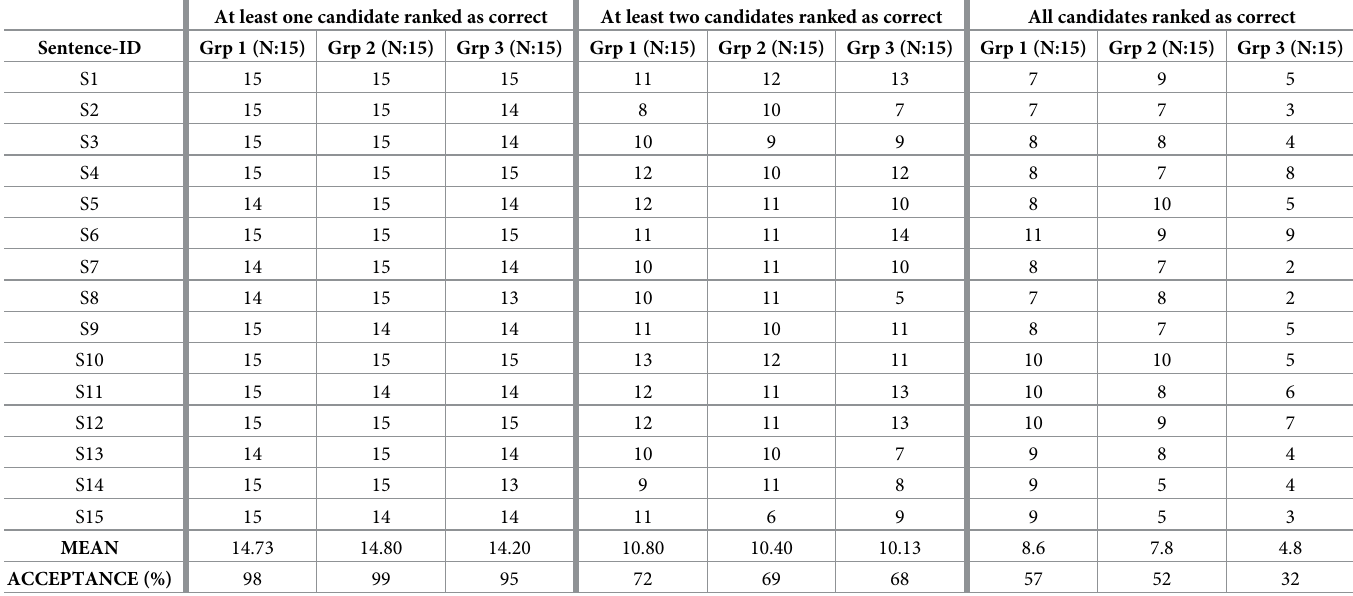
Table 7. Task2: Number of cases where at least one candidate, two candidates and all candidates were ranked as correct, sorted by groups and sentences where Grp 1: older people, Grp 2: people with intellectual disabilities and Grp 3: control users. At least one candidate ranked as correct At least two candidates ranked as correct All candidates ranked as